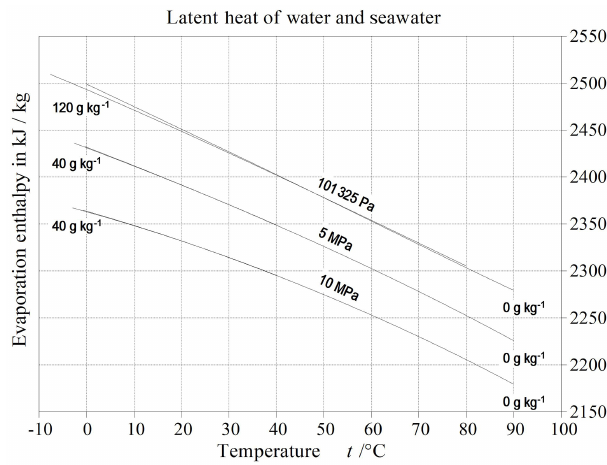
Figure 5. Isobaric evaporation enthalpy of water, indicated by “0gkg − 1 ”, and of seawater with salinities of 120gkg − 1 at 101325Pa and 40gkg − 1 at 5MPa and 10MPa as functions of the temperature and computed from TEOS-10. Here, the latent heat of evaporation of seawater is derived from the total heat capacity of a two-phase seawater–air composite, reduced by the two separate single-phase heat capacities involved. The salinity corrections to the latent heats of pure water are very small. At high pressure the va- lidity of the Gibbs function of seawater is restricted to maxima of 40gkg − 1 and 40 ◦ C, but at atmospheric pressure it is valid up to 120gkg − 1 and 80 ◦ C. The lower temperature bounds shown are the particular freezing points of water or seawater (Feistel et al.,